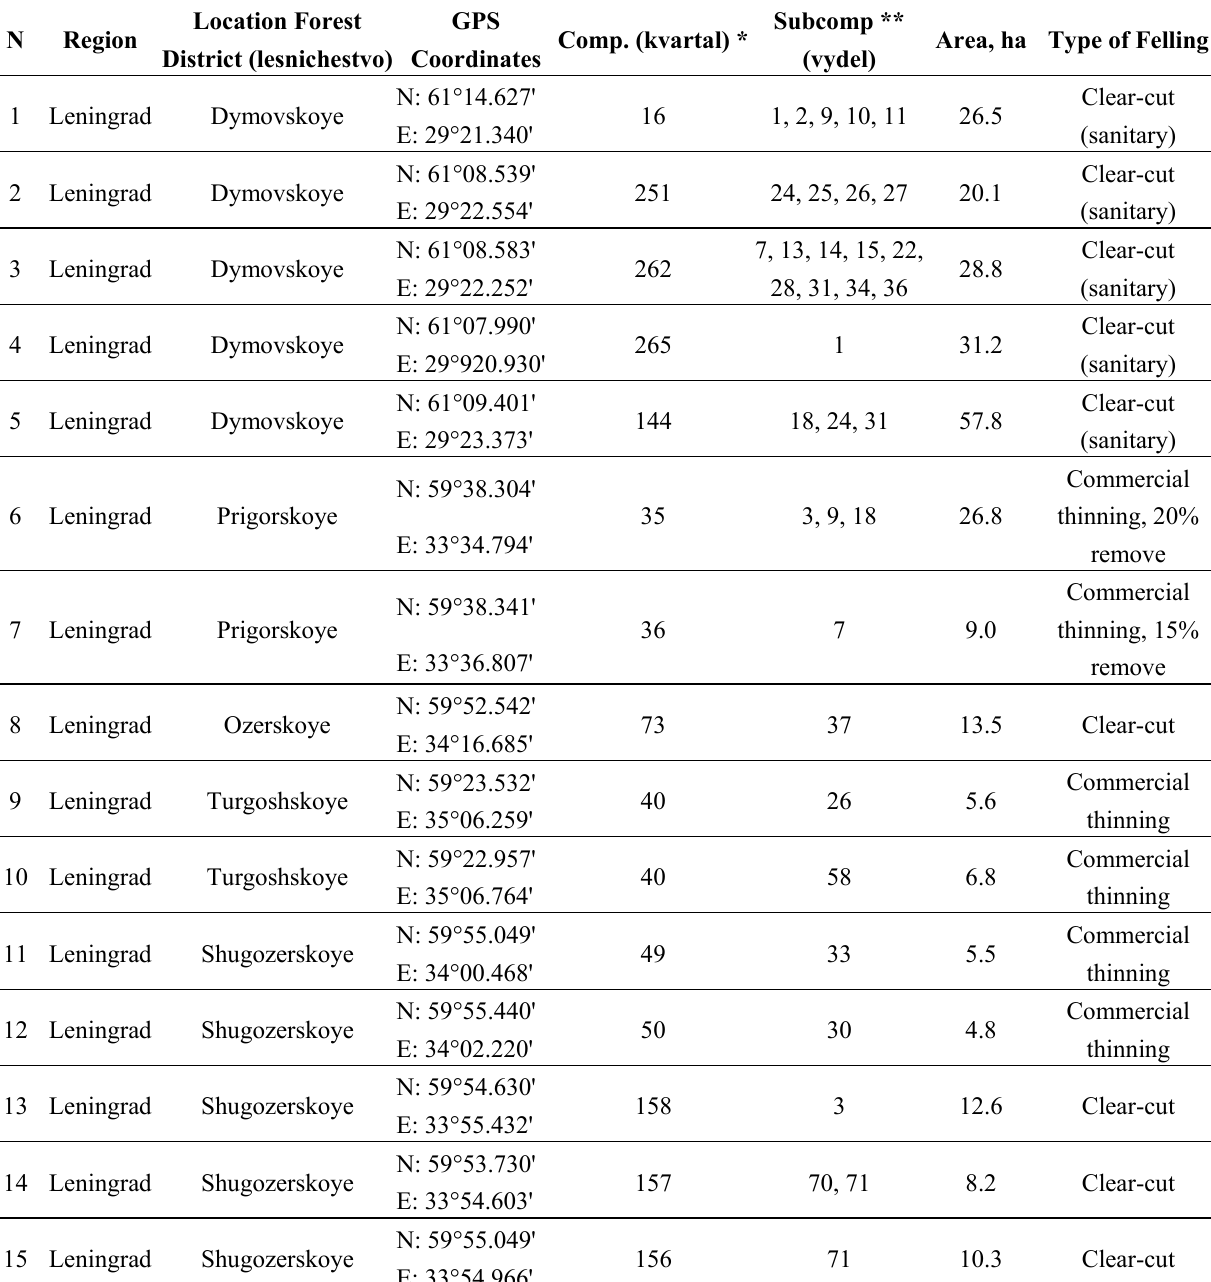
Table 5. Forest site audits at the forest management unit